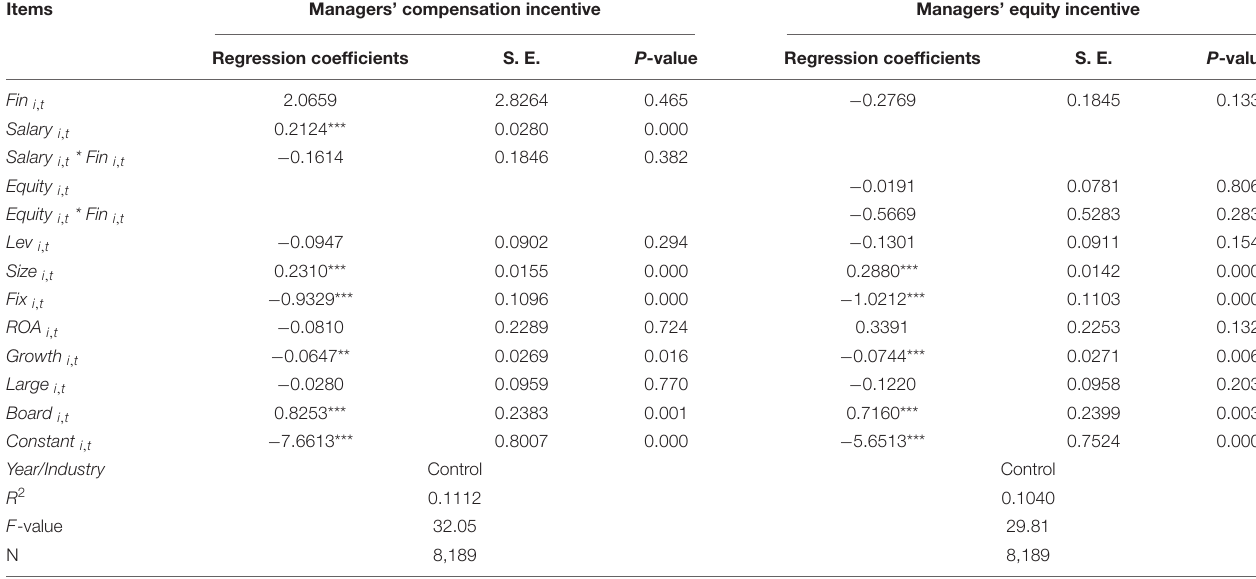
TABLE 10 | The effect of manager’s incentive on